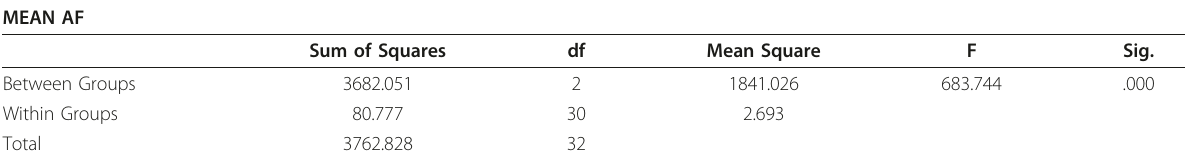
Table 2 ANOVA for maspin MEAN AF